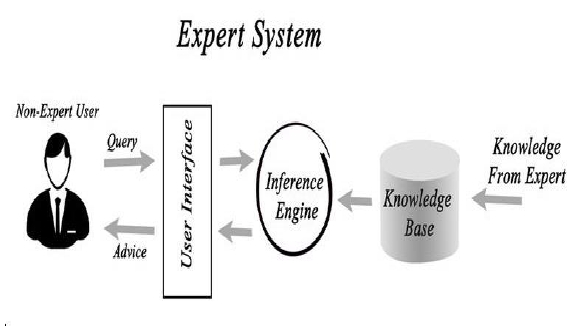
Figure 4. A typical Expert Security